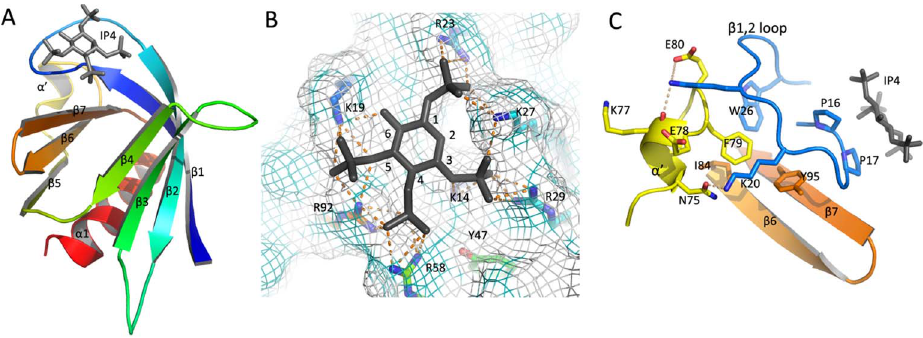
Fig. 3. The 3D model of GAB1 PH domain. A. The overall structure of IP4-bound GAB1 PH domain. The protein secondary structure is shown in ribbons and IP4 is shown in sticks. B. A close view of the IP4 binding site. The critical residues for IP4 binding are labeled, and IP4 is in black stick with position labeled. The hydrogen bonds are illustrated with dashes. C. Interactions between a 9 -helix and b 5,6 loop. The residues mediating the interactions are highlighted with sticks and hydrogen bonds are illustrated with dashes.